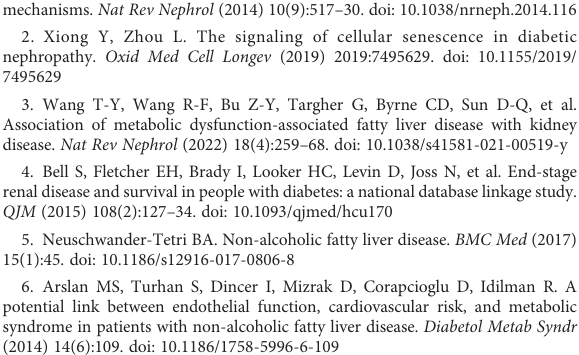
SUPPLEMENTARY FIGURE 1 The functional similarity between NAFLD and DN. (A) Comparison of functional enrichment of DN and healthy controls. (B) Comparison of functional enrichment of NAFLD and healthy controls. SUPPLEMENTARY FIGURE 2 The expression level of all DEGs in NAFLD merged dataset (A) and DN merged dataset (B) . SUPPLEMENTARY FIGURE 3 Immune characteristics of NAFLD and DN Comparison of immune characteristics between NAFLD and DN. (A) An intuitive picture of the percentage of the 22 immune cells in NAFLD patients and DN patients. (B) The proportion of 22 immune cells in two diseases. (C) The expression of 28 immune cells in two diseases. SUPPLEMENTARY FIGURE 4 Rank the importance of the RF model. SUPPLEMENTARY FIGURE 5 The predictive ef fi ciency of the 10 crosstalk genes in NAFLD (A) and DN (B) . SUPPLEMENTARY FIGURE 6 The expression of the 10 crosstalk genes in NAFLD (A) and DN (B) . SUPPLEMENTARY FIGURE 7 The protein-protein interaction network of the NAFLD relatedTFs and the top 180 signi fi cant differentially expressed genes in DN merged